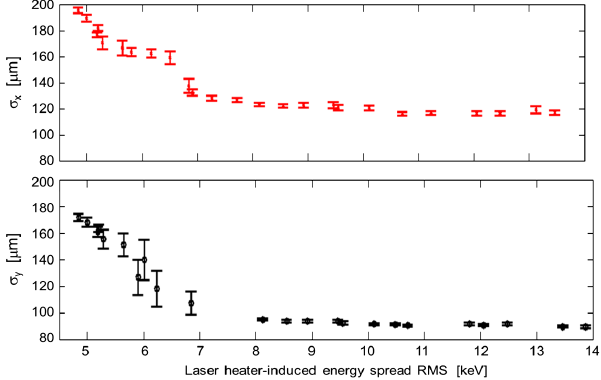
FIG. 12. Measured transverse electron beam dimensions in X and Y at the linac exit as a function of the LH heating strength. For these particular measurements the laser spot size was 130 × 130 μ m 2 (rms) and the pulse duration was ∼ 15 ps